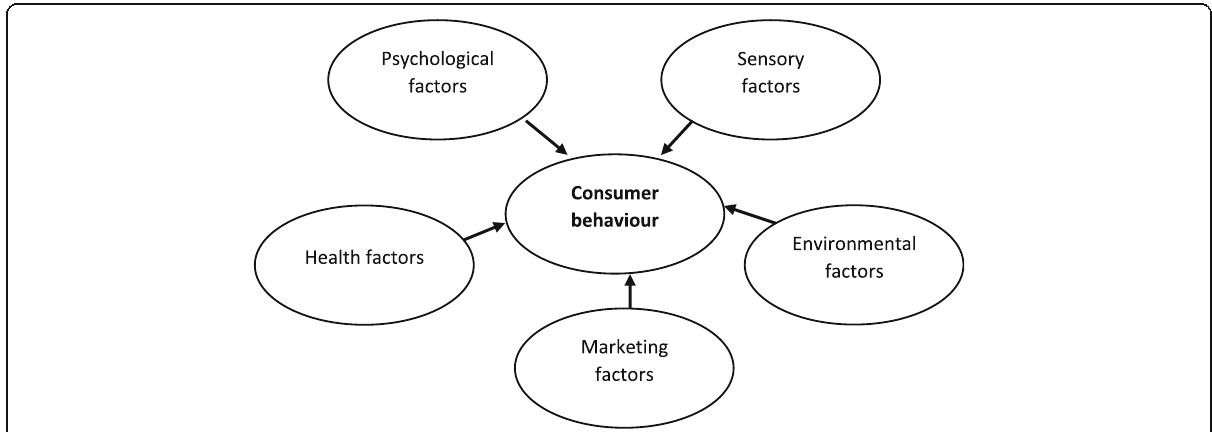
Fig. 1 Factors affecting consumer behaviour in the food